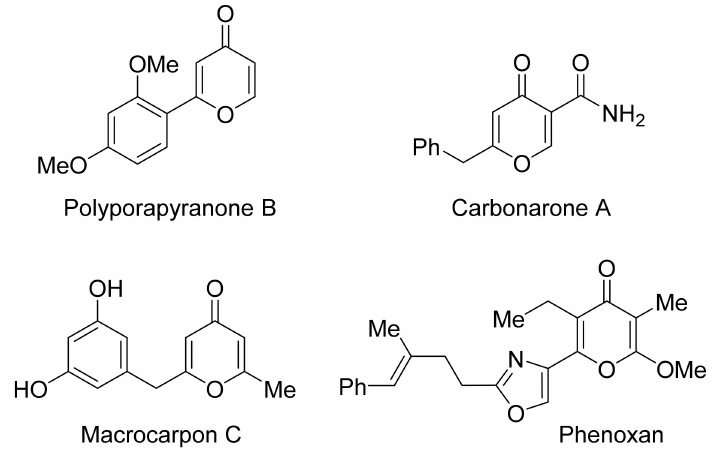
Figure 1. Some representative examples of biologically important arylated